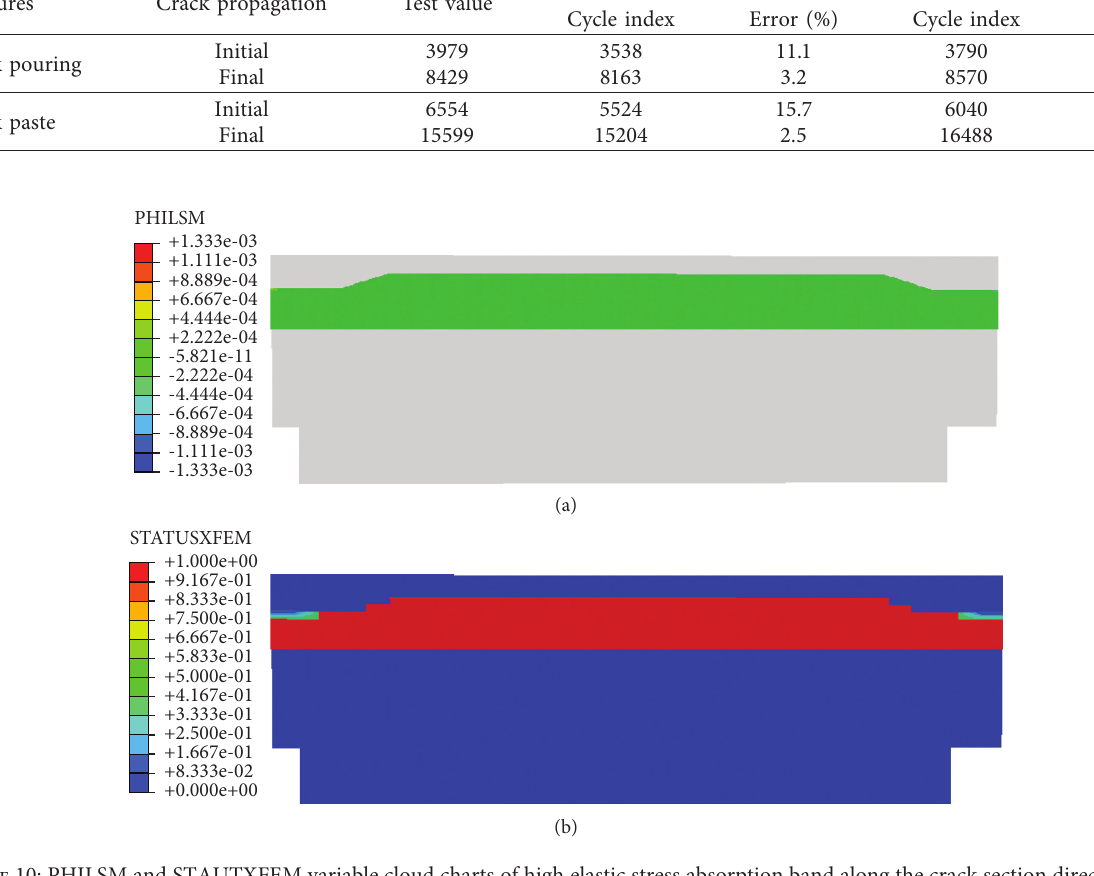
Figure 10: PHILSM and STAUTXFEM variable cloud charts of high elastic stress absorption band along the crack section direction when reaching 7010 times. (a) PHILSM variable cloud chart. (b) STAUTXFEM variable cloud chart. ( Note . The green part in (a) represents the crack surface. The red part in (b) indicates that it has been cracked while the light green part indicates that it is near to being